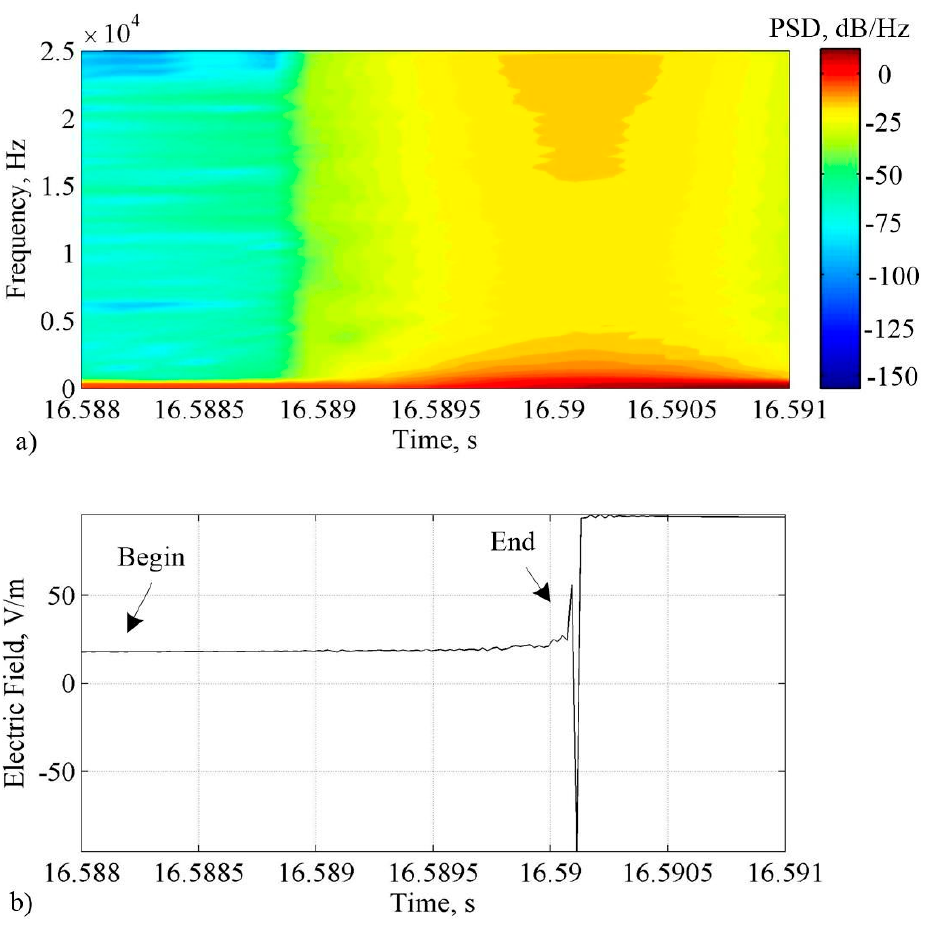
Figure 8. Detection of the positive leader at the far distance to the lightning channel. It was obtained by the LLDN station on 7 June 2020 at 18:37:16.5901 UTC (see Case #11 in Table 1). The time in this plot corresponds to the reported positive return stroke timestamp. In panel ( a ), the PSD spectrogram of lightning’s positive leader stage is shown and corresponds with the course of its E-field signature given in panel ( b ). Here, the STFT parameters were chosen the same as in Figure